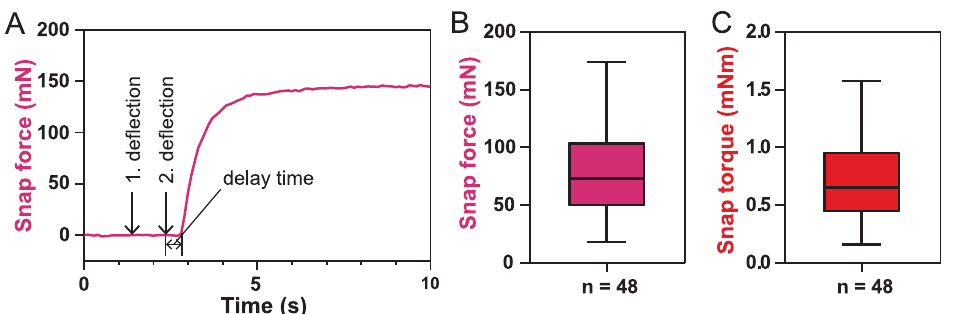
Fig 5. Snap force and torque measured with the snap force sensor. (A) Typical force curve after trap closure induced by double deflection. (B) Descriptive statistics of the snap force right below the marginal teeth and (C) the closing torque around the midrib of a triggered flytrap. The horizontal line indicates the median, the box the 25th and 75th percentiles, and the whiskers extend to the most extreme data points. For the underlying data, see sheets Fig 5A to Fig 5C in S1 Data.